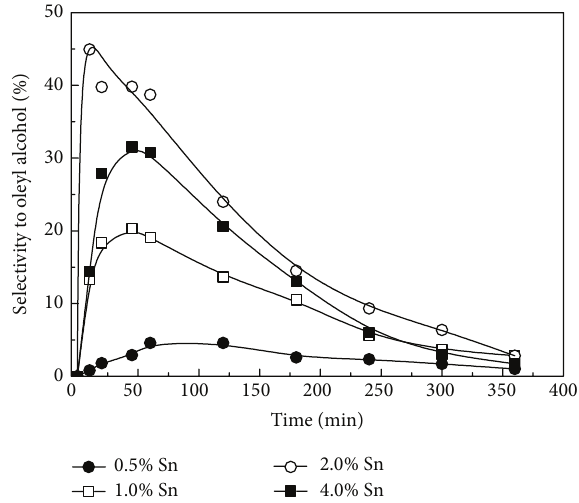
Figure 7: Oleyl alcohol selectivity as a function of reaction